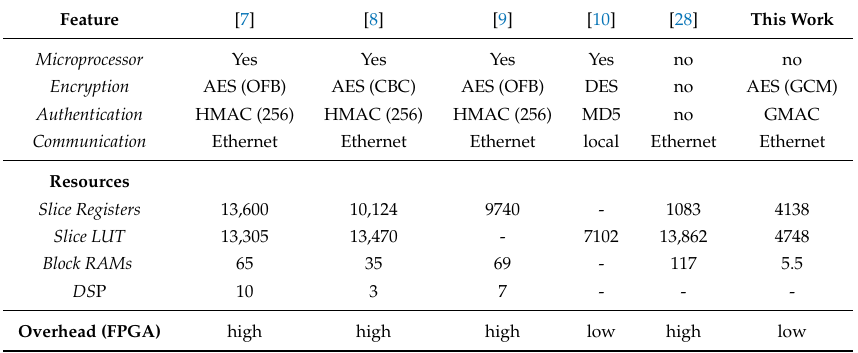
Table 6. Comparison with related works that focus on the configuration of a FPGA through